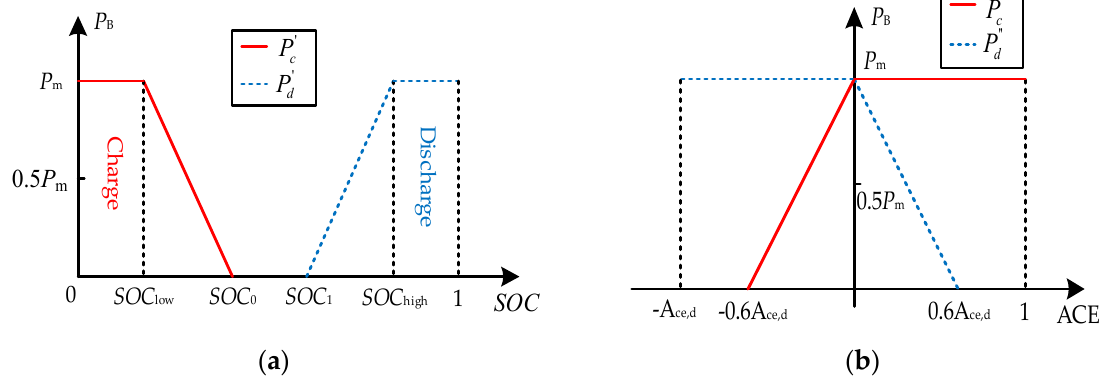
the BESS is shown in Figure 5.